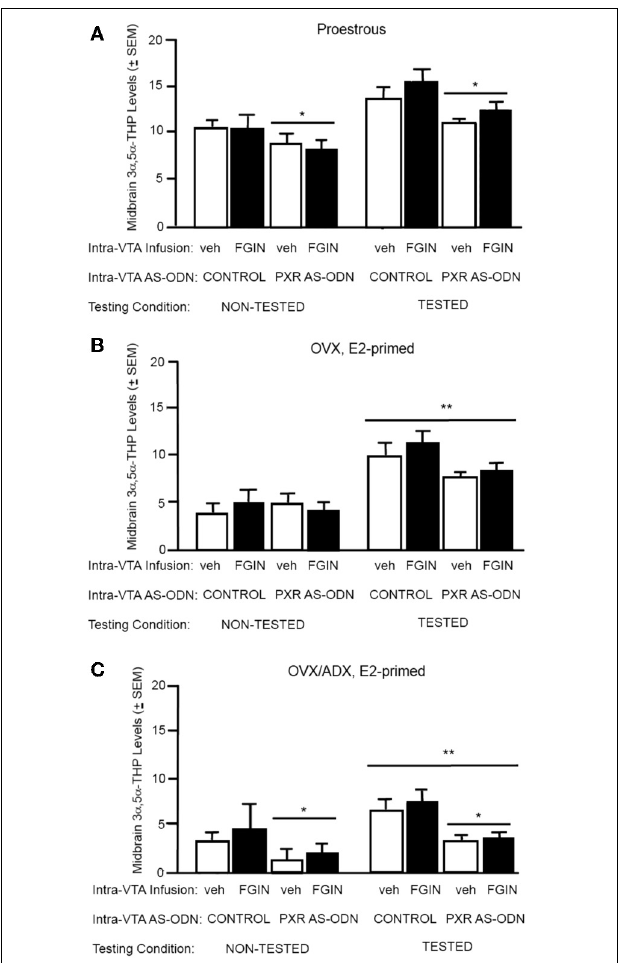
FIGURE 3 | (A) Depicts the mean ( ± s.e.m.) 3 α ,5 α -THP levels in the midbrain of proestrous non tested rats infused with control and vehicle (veh, n = 5) or control + FGIN ( n = 4), or pregnane xenobiotic receptor (PXR) antisense deoxynucleotides (AS-ODNs) and veh ( n = 6), or PXR AS-ODN + FGIN ( n = 6) or behaviorally-tested rats infused with control + veh ( n = 15), control + FGIN ( n = 15), PXR AS-ODN + veh ( n = 8), or PXR AS-ODN + FGIN ( n = 13) in Experiment 2. Rats infused with PXR AS-ODN had a mean 1.8 fold lower PXR expression in the midbrain compared to control infusions in Experiment 2 (data not shown). (B) Depicts the mean ( ± s.e.m.) 3 α ,5 α -THP levels in the midbrain of ovariectomized (OVX) estradiol (E2)-primed non tested rats infused with control + veh ( n = 5), control + FGIN ( n = 6), PXR AS-ODN + veh ( n = 5), PXR AS-ODN + FGIN ( n = 5), or behaviorally-tested rats infused with control + veh ( n = 8), control + FGIN ( n = 7), PXR AS-ODN + veh ( n = 7), or PXR AS-ODN + FGIN ( n = 6) in Experiment 3. Rats infused with PXR AS-ODN had a mean 1.5 fold lower PXR expression in the midbrain compared to control infusions in Experiment 3 (data not shown). (C) Depicts the mean ( ± s.e.m.) 3 α ,5 α -THP levels in the midbrain of OVX/adrenalectomized (ADX), E2-primed rats that were non tested and infused with control + veh ( n = 6), control + FGIN ( n = 5), PXR AS-ODN + veh ( n = 5), PXR AS-ODN + FGIN ( n = 5), or behaviorally-tested and infused with control + veh ( n = 9), control + FGIN ( n = 5), PXR AS-ODN + veh ( n = 8), or PXR AS-ODN + FGIN ( n = 5) in Experiment 4. Rats infused with PXR AS-ODN had a mean 1.4 fold lower PXR expression in the midbrain compared to control infusions in Experiment 4 (data not shown). ∗ above a line indicates a significant effect of PXR AS-ODNs compared to control. ∗∗ above a line indicates significant effect of testing compared to non-tested rats ( P < 0 . 05).